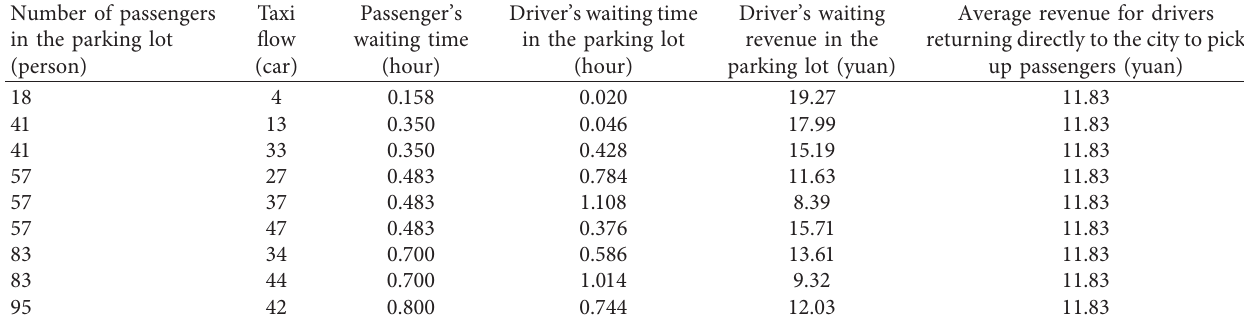
Table 3: The relationship between waiting time and diver’s revenue.